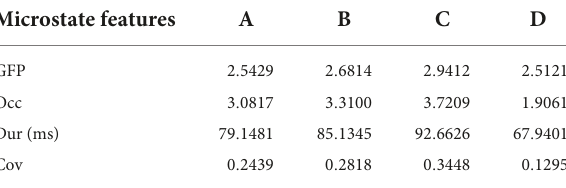
TABLE 1 Microstate features GFP, Occ, Dur, and Cov for each prototype